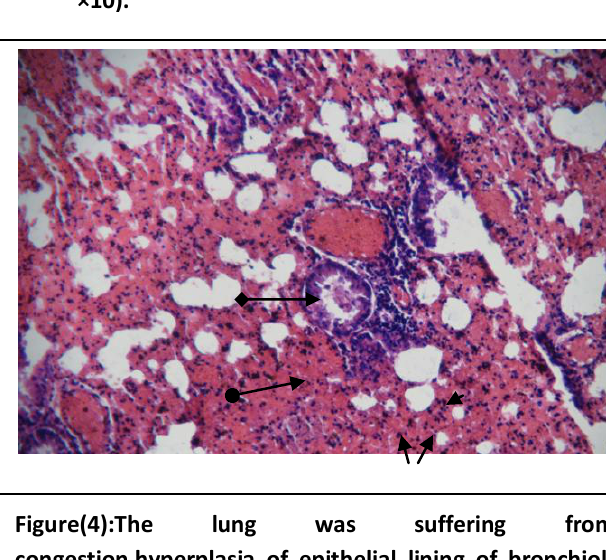
Figure(3):There,acutecellular degeneration (swelling) of renal tubules( ) and boman space dilatation( ) in the kidney. (H&E ×40).